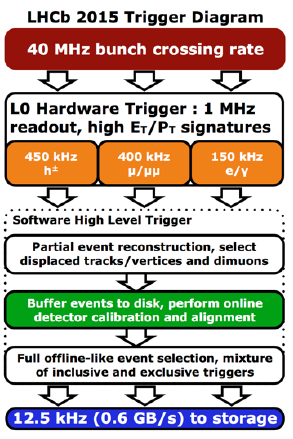
Figure 4. LHCb 2015 Trigger Figure 3. Standard DIRAC job submission cycle.